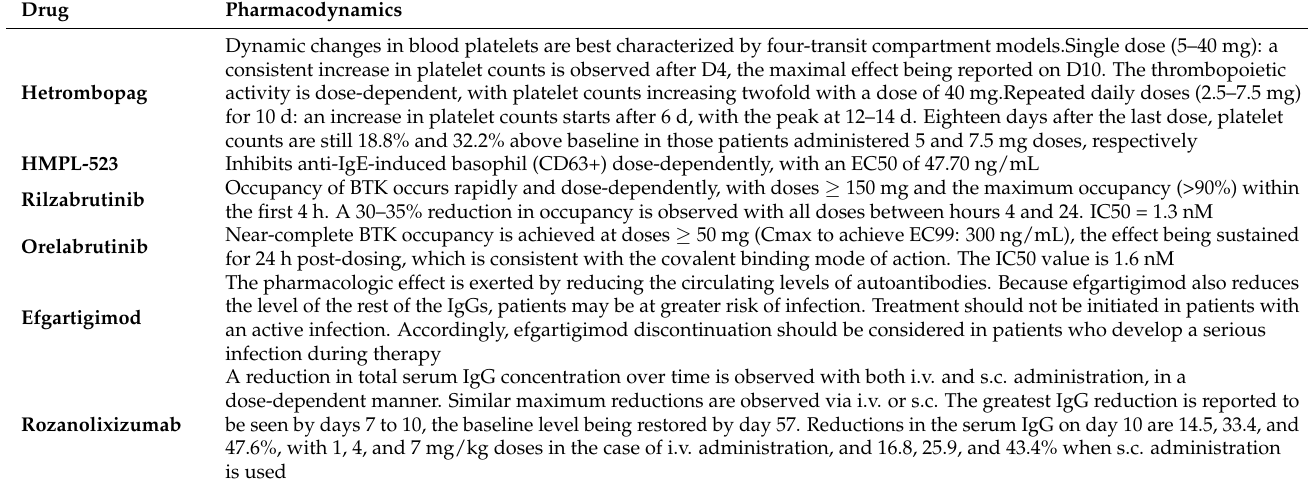
Table 7. Pharmacodynamics of the drugs under clinical investigation to treat ITP